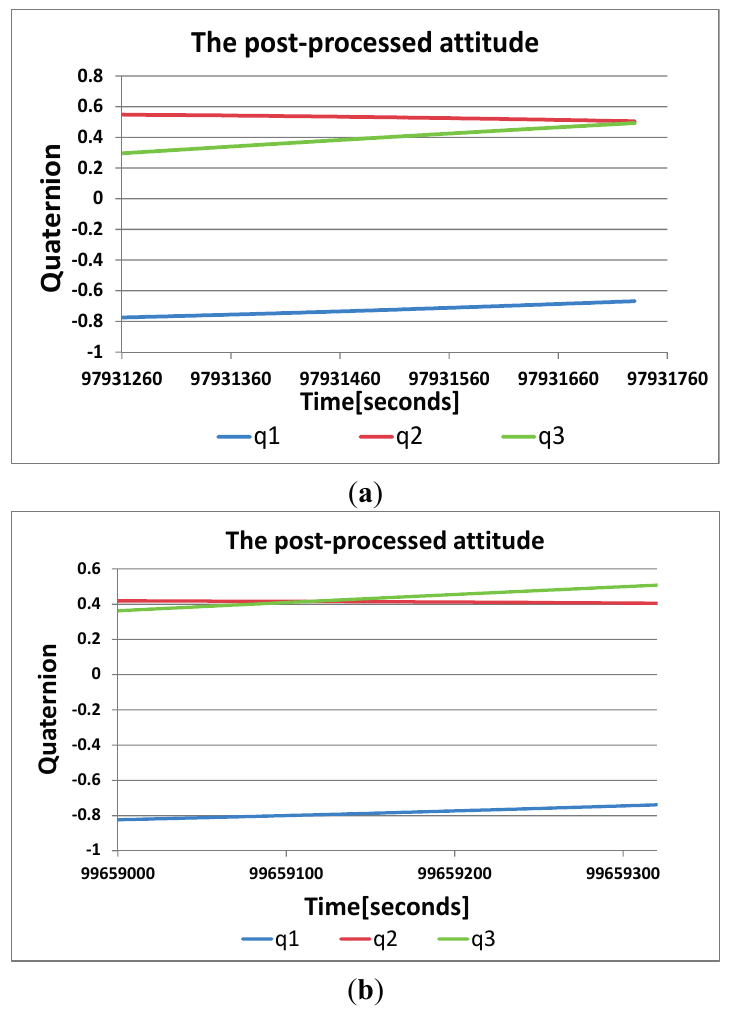
Figure 6. Post-processed attitude results (quaternion). ( a ) Post-processed attitude results (the 457th track); ( b ) post-processed attitude result (the 785th